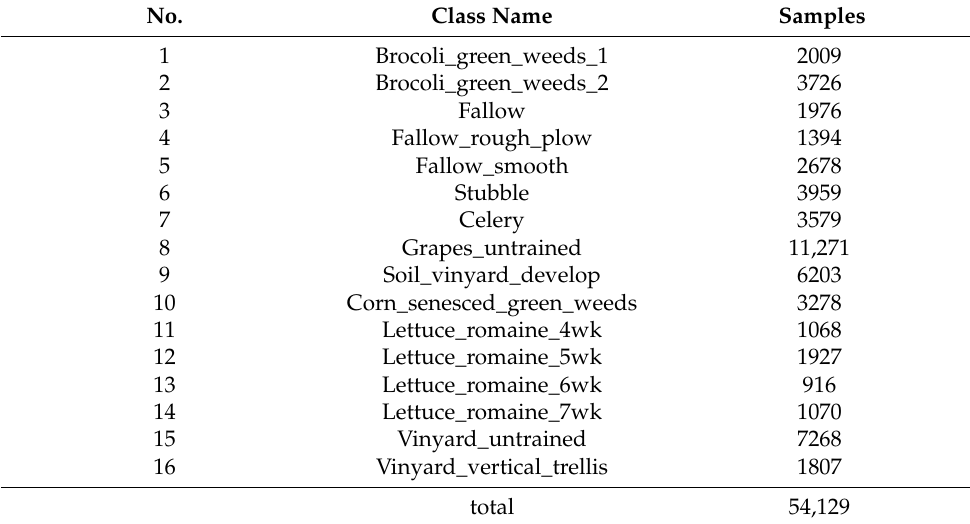
Table 5. Samples distribution for Salinas